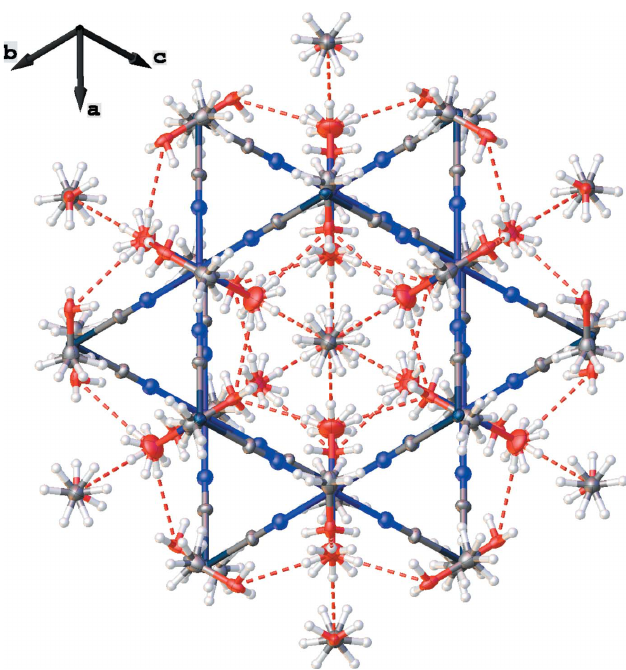
Figure 3 View of the crystal structure of the title compound showing the methanol solvent molecules, which are located in hexagonal pores. Hydrogen bonds are shown as red dashed